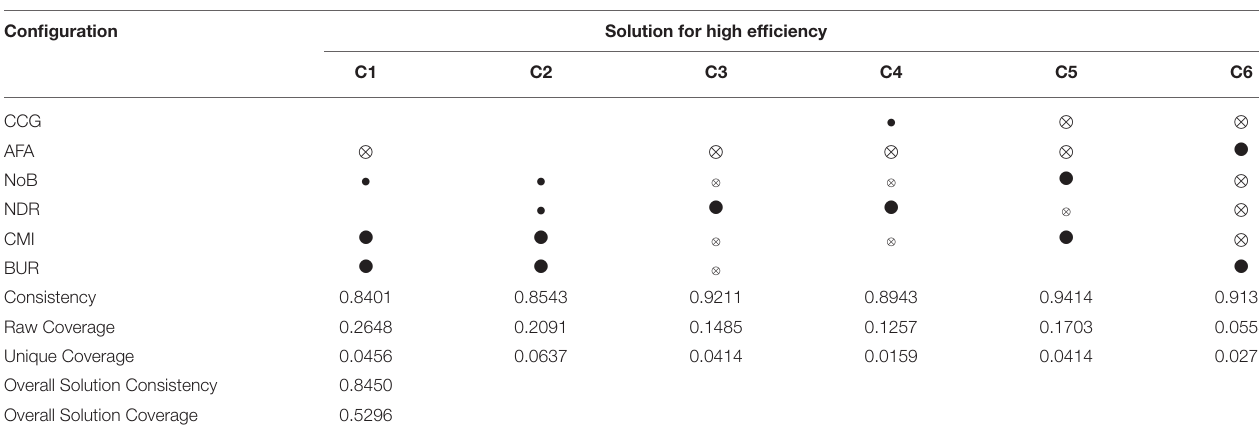
TABLE 7 | Results of robustness test.